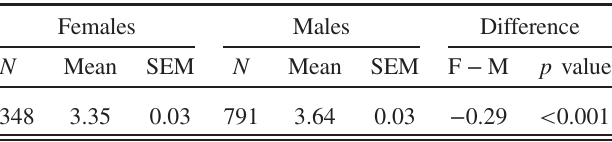
TABLE I. Average course grades for female and male students passing the electromagnetism course, and standard error of the